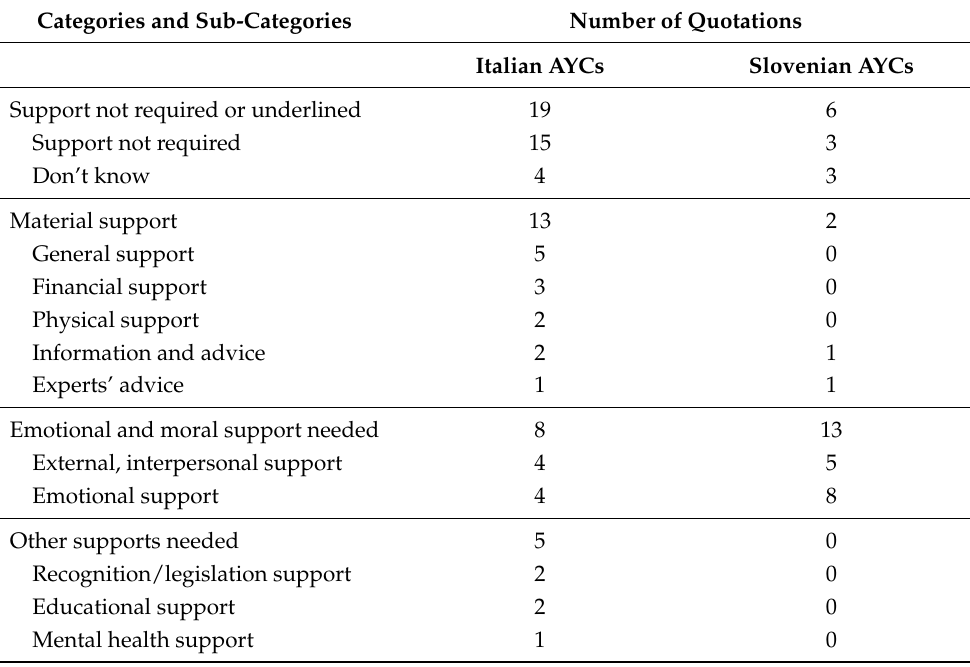
Table 4. Categories and sub-categories related to support needs of AYCs of GrPs.